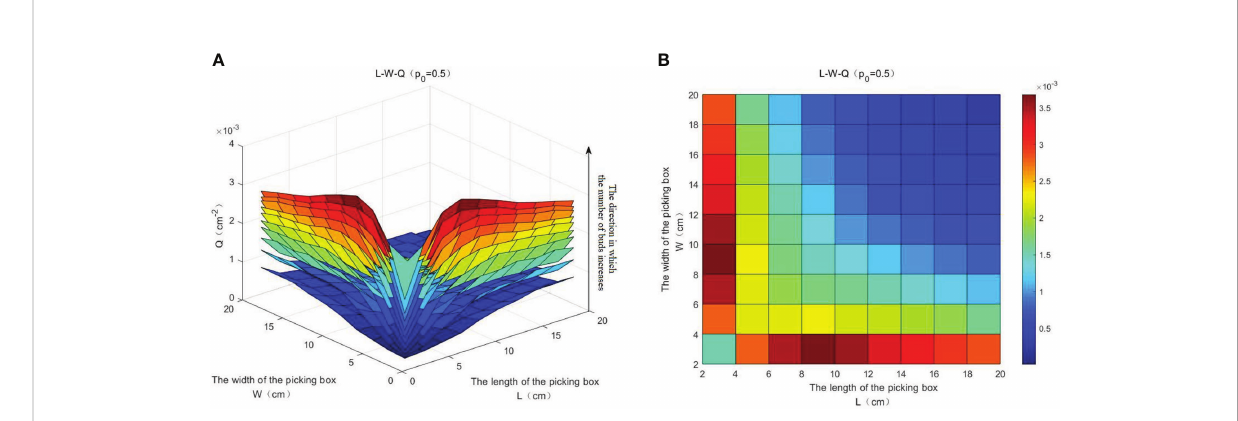
FIGURE 15 The relationship between L , W , and Q . (A) The relationship between L , W , and Q . (B) The relationship between L , W , and Q (top